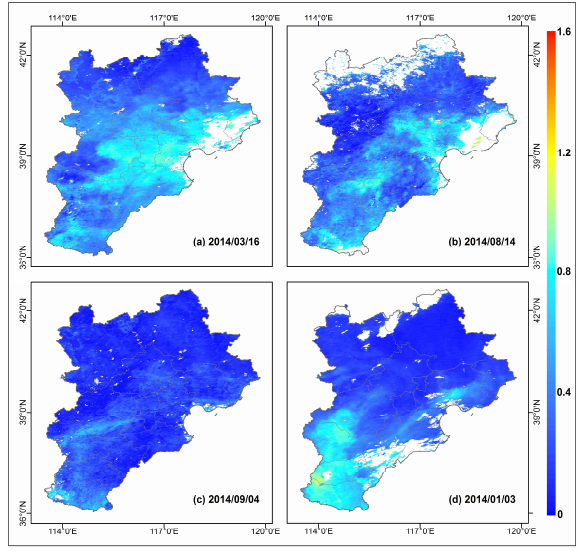
Figure 2. AOD images of MCD19A2 in BTH